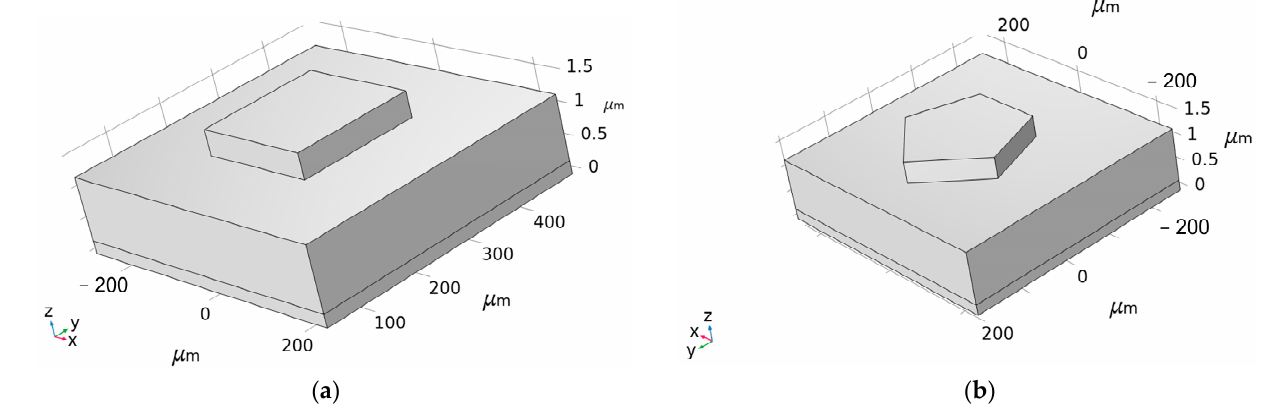
Figure 9. Three-dimensional models of different electrode shapes: ( a ) square electrode and ( b ) pentagonal electrode.